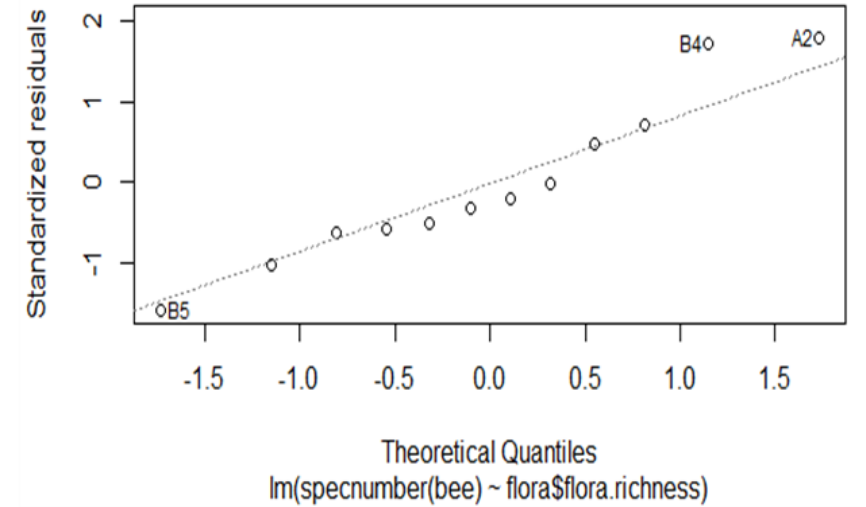
F IGURE 5: Effect of floral resources richness on bee species